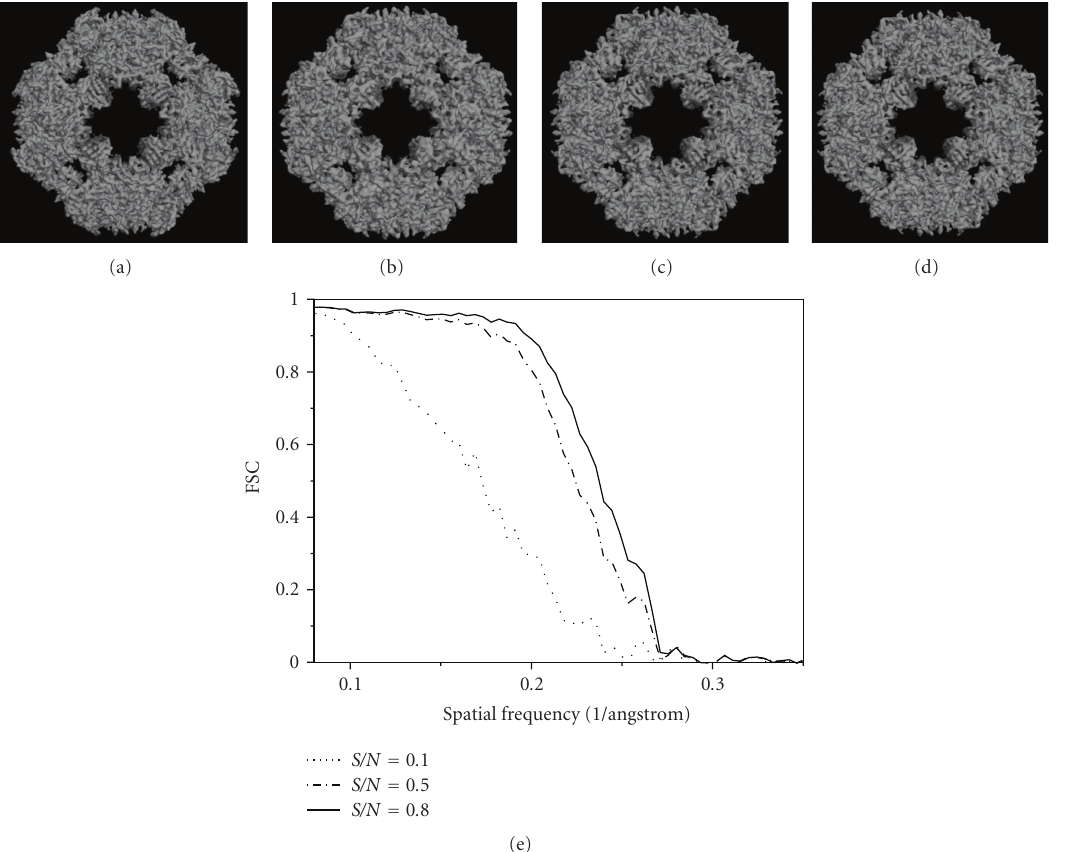
Figure 6: 3D structures reconstructed by the OSAF method viewing along the 4-fold axis of DegP 24 protein with S/N = 0 . 1, 0.5, and 0.8. (a) 3D structures of SSM, (b) the result for S/N = 0 . 1, (c) S/N = 0 . 5, (d) S/N = 0 . 8, (e) the FSC curves for di ff erent noise levels.